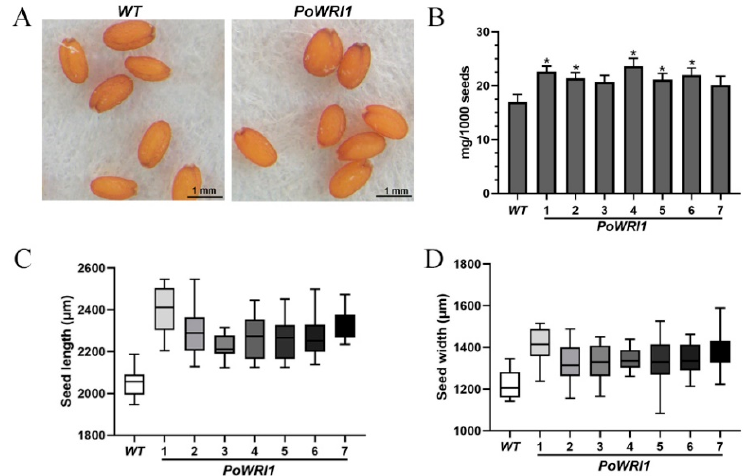
Figure 5. Phenotypic observation of transgenic Arabidopsis . ( A ) Dry seeds of WT and PoWRI1 observed under a stereomicroscope. Bars indicate 1 mm. ( B ) 1000 dry seeds weigh of WT and PoWRI1 (Line 1–7). Error bars are s.e. ( n = 3). * indicates significant differences between WT and PoWRI1 (Line 1–7) ( p < 0.05). ( C ) Seed length of WT and PoWRI1 (Line 1–7). Error bars are s.e. ( n = 23). ( D ) Seed width of WT and PoWRI1 (Line 1–7). Error bars are s.e. ( n =